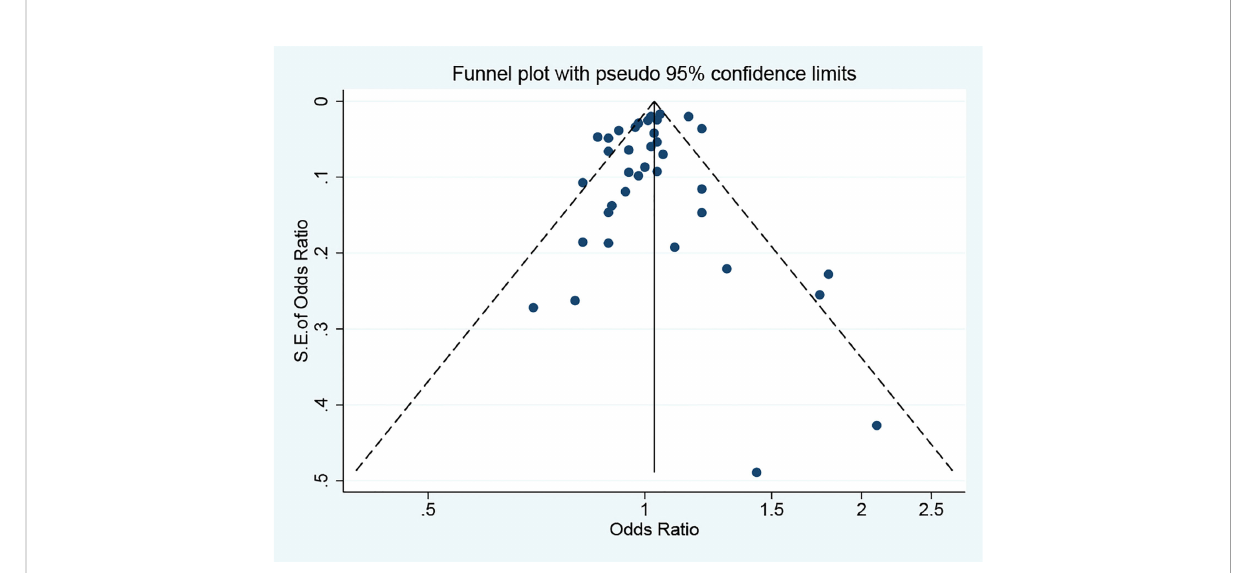
FIGURE 5 Funnel plot for identifying the publication bias. S.E., standard error. The circles alone are real studies. The vertical lines represent the summary effect estimates, and the dashed lines represent pseudo-95% con fi dence interval